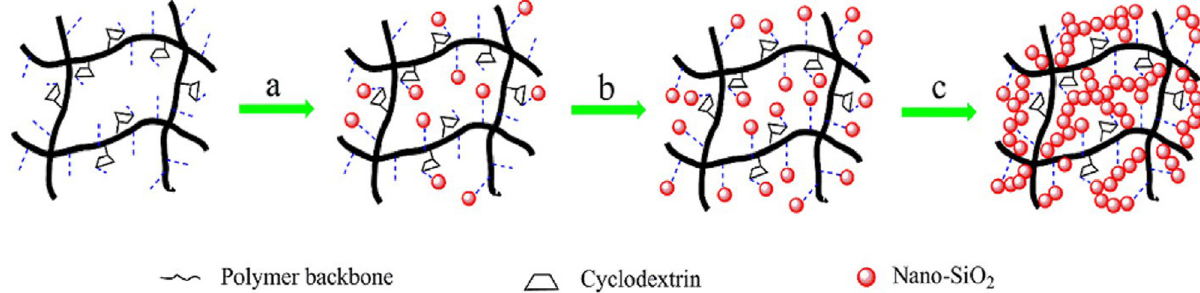
Figure 1: Illustration of the adsorption of nano - SiO 2 onto ASM chains for a fi xed ASM concentration: ( a ) nano - SiO 2 attached to ASM chains via hydrogen bonds, ( b ) saturated state ( all the sites attached by nano - SiO